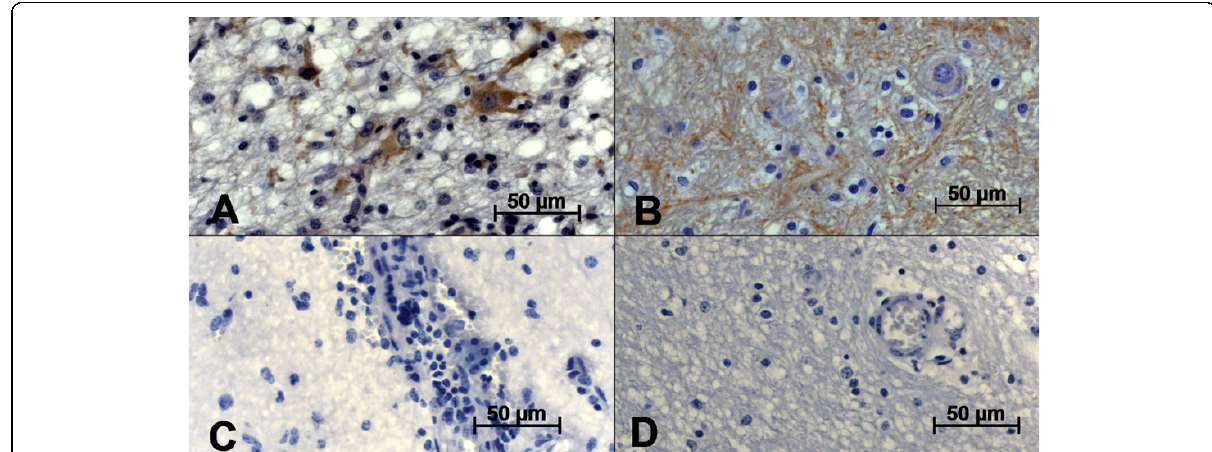
Figure 5 Photomicrography of immunohistochemical SNAP-25 antigen detection in the frontal cortex of BoHV-5-infected calves (A-B) and control group (C-D) . A) positive immunolabeling of neuronal and glial cells; B) positive labeling dispersed in the parenchyma; C and D) no